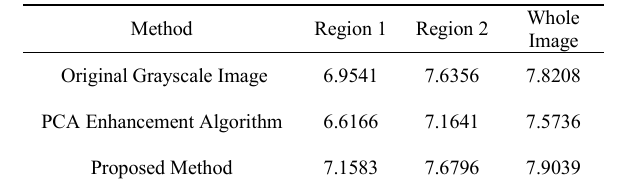
Figure 3 . Comparison of segmentation results